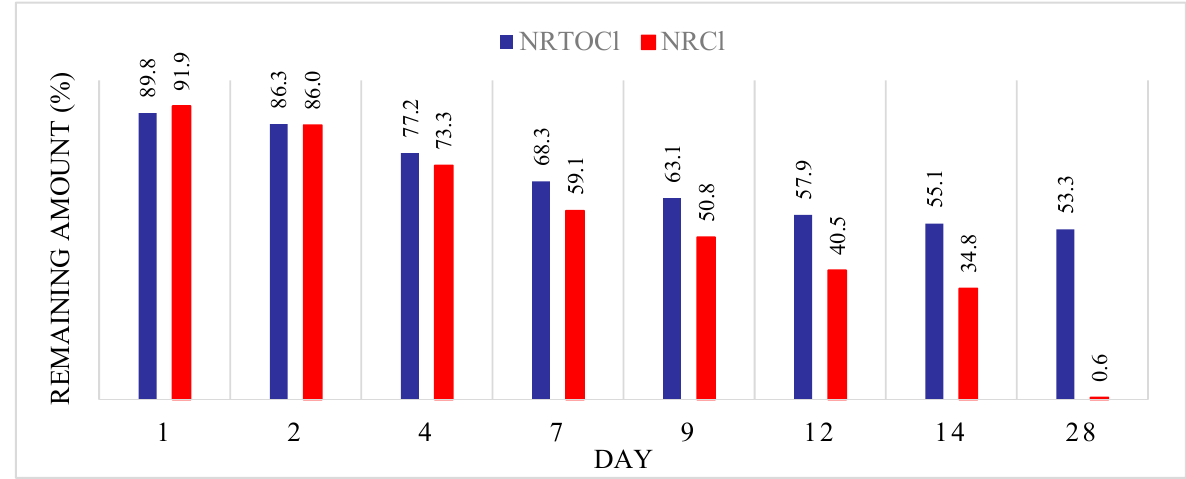
The concentration of this sample was 1000 mg/L.